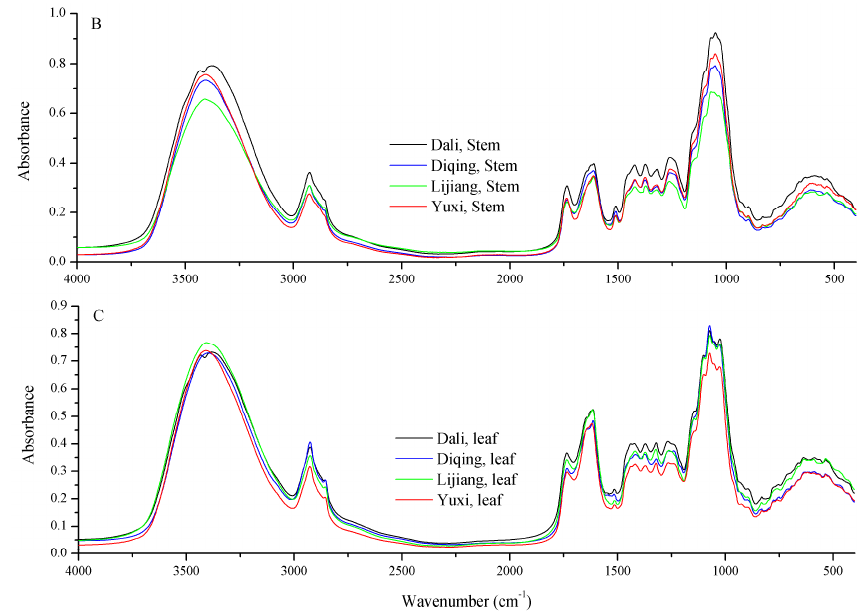
Figure 2. The average FT-IR spectra of root ( A ), stem ( B ) and leaf ( C ) in G. rigescens from different geographical origins (Dali, Lijiang, Diqing and Yuxi) in the 4000–400 cm − 1 range .